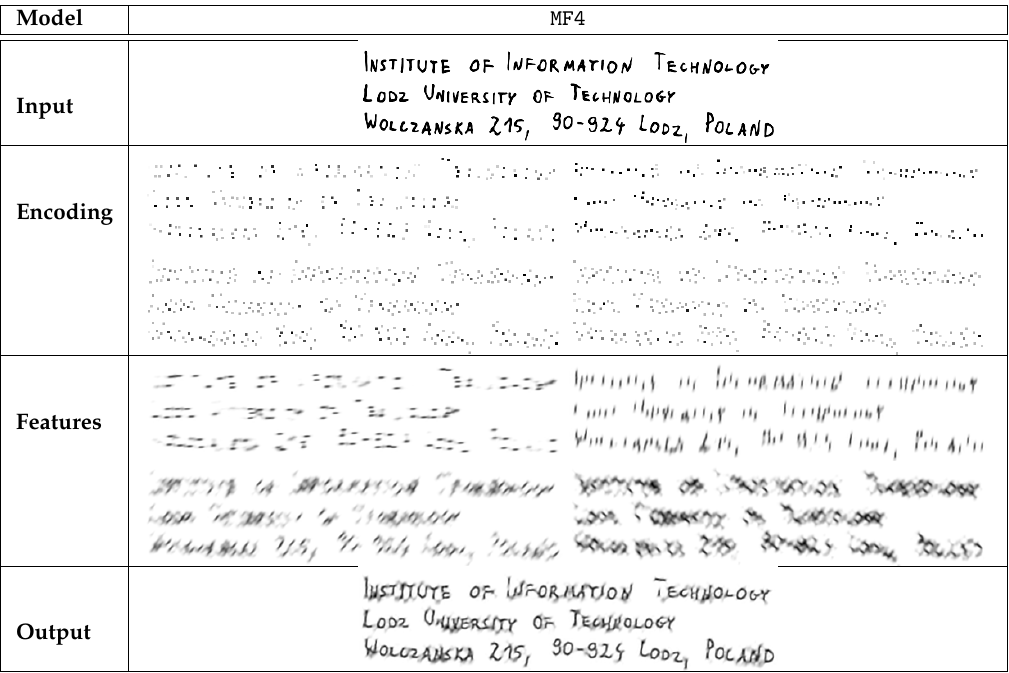
Figure 14. Sample encoding of a postal address scan that contains both digits and letters, performed with the MF4 model. The presented feature-specific decodings were generated in the same way as those shown in Figure